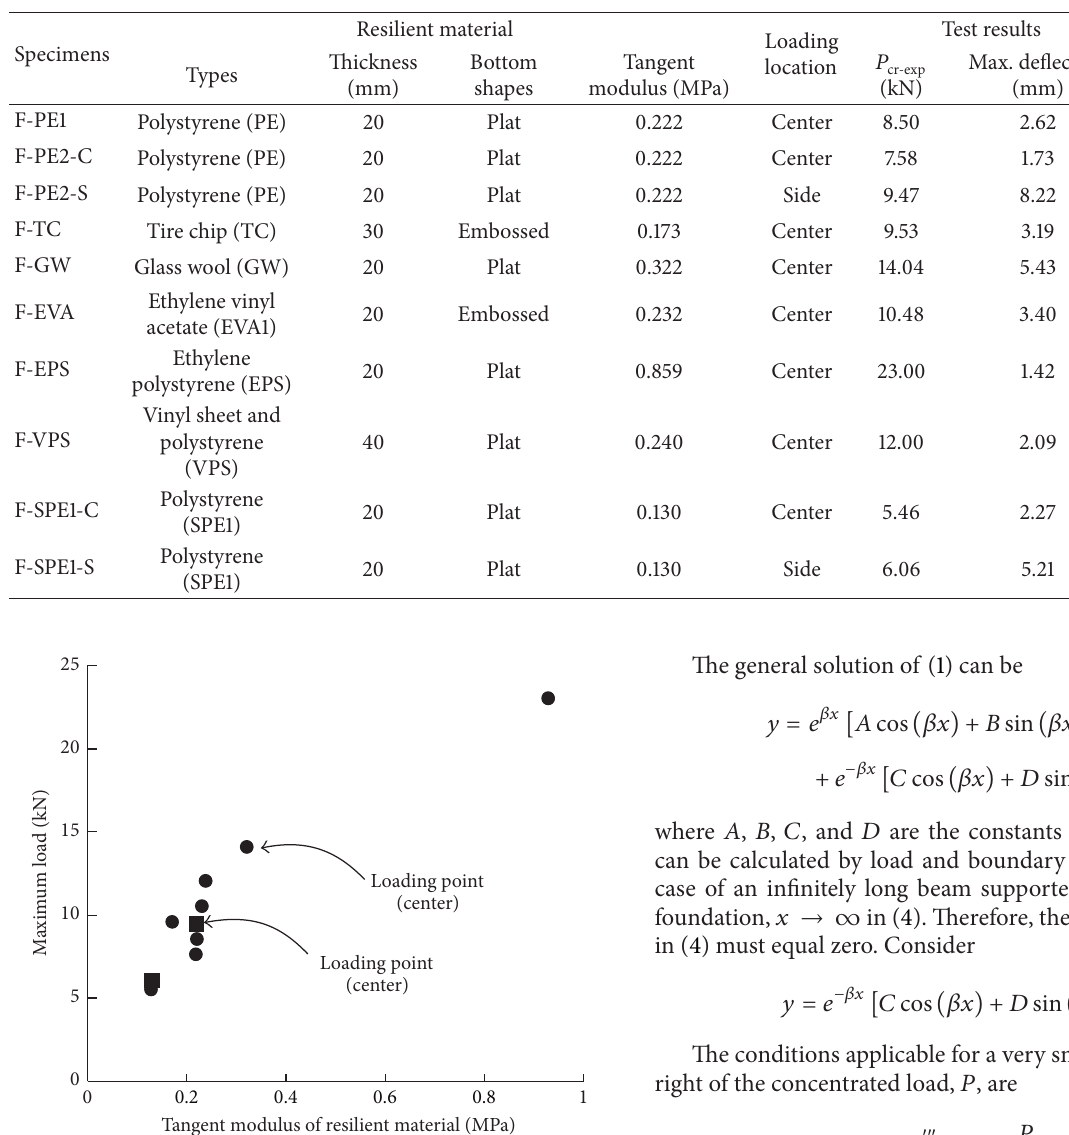
Table 2: Specification of floating floor specimens and test results.